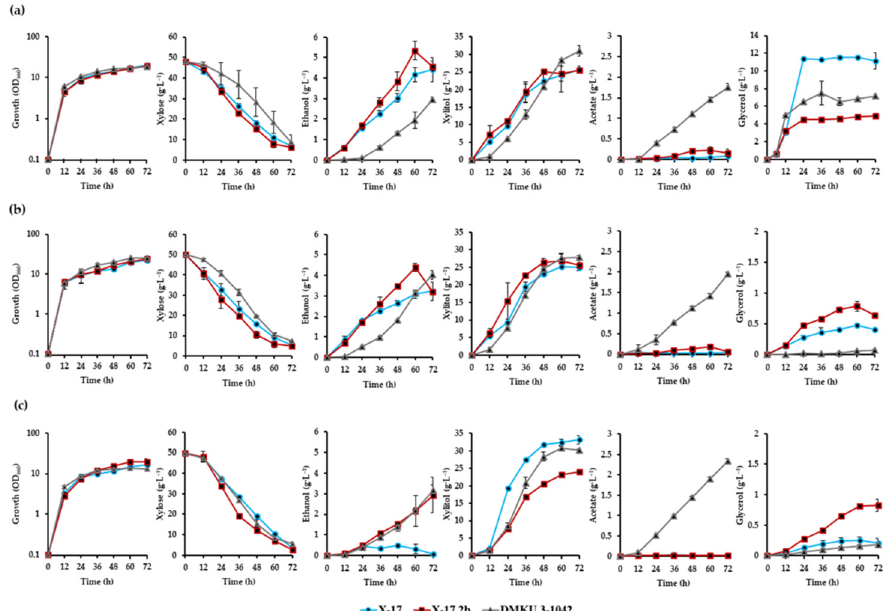
Figure 3. Growth and metabolite profiles of C. tropiclis X-17 ( filled circles ), adapted strain C. tropicalis X-17.2b ( filled squares ) and K. marxianus DMKU 3-1042 ( filled triangles ). Cells were grown in YP media containing 50 g · L − 1 xylose at ( a ) 35 °C, ( b ) 37 °C and ( c ) 42 °C under a shaking condition at 100 rpm, and samples were taken every 12 h until 72 h of incubation. Bars represent the ±SD of values from experiments performed in triplicate.